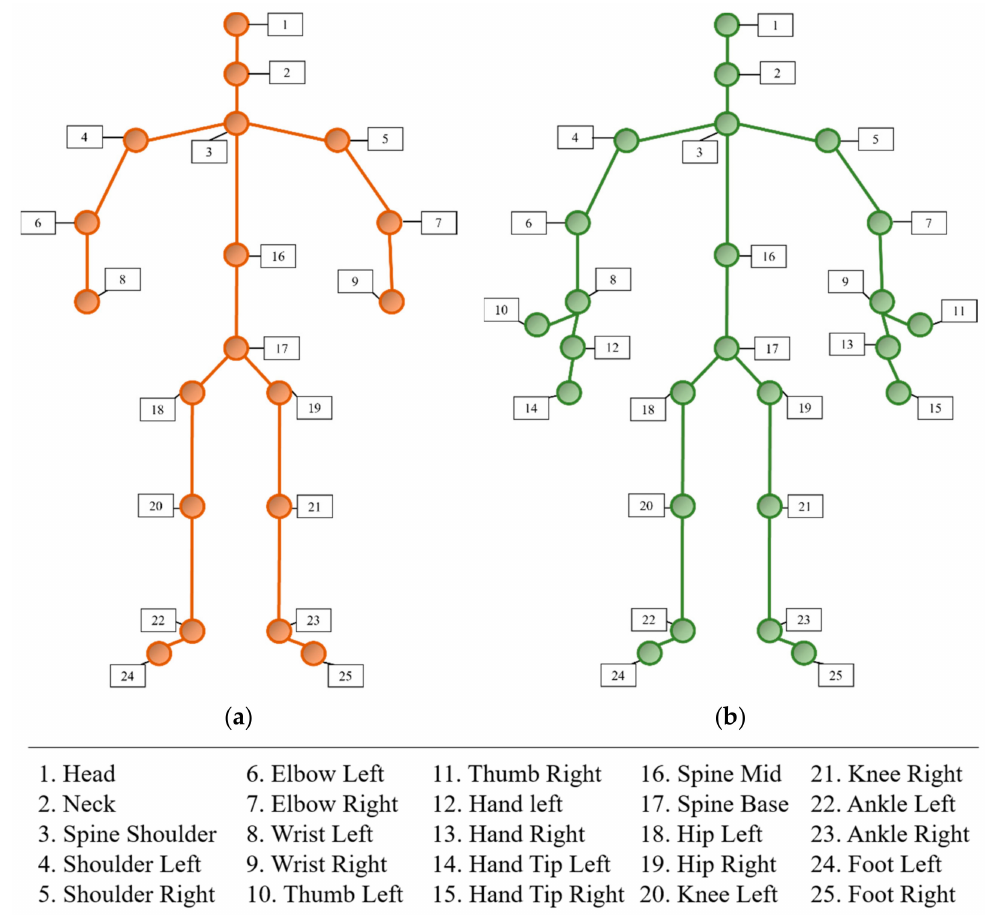
Figure 3. Visualization of the differences between the 19 joints used in [7] and the 25 joints. ( a ) 19 human joints; ( b ) 25 human joints.